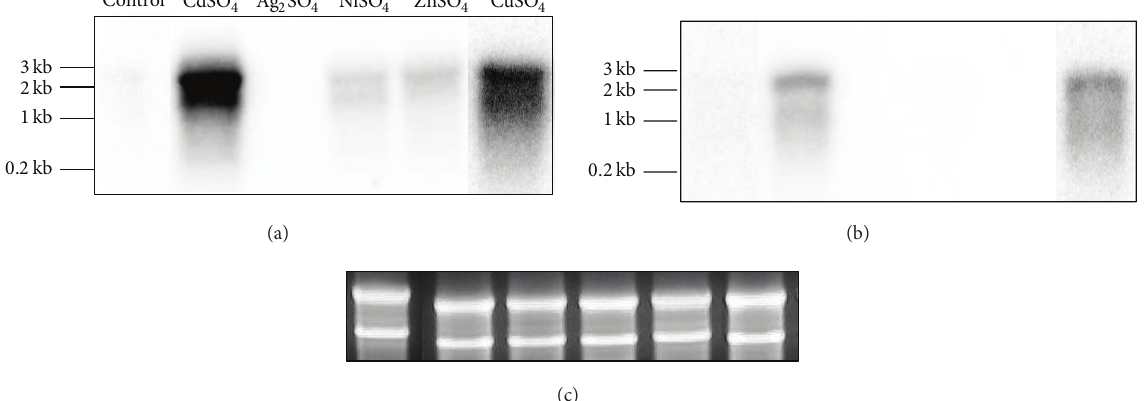
Figure 6: Northern blot analysis to determine the expression of S. metallicus copA1 (a) and copA2 (b) putative genes in response to various metals. S. metallicus total RNA was extracted from cultures grown either in the absence (control) or the presence of CuSO 4 (50mM), Ag 2 SO 4 (0.08mM), NiSO 4 (15mM), ZnSO 4 (50mM), and CdSO 4 (2mM). P 32 -radioactivelly labelled DNA fragments annealing to copA1 and copA2 sequences, respectively, were used as probes. (c) shows rRNAs as total RNA loading